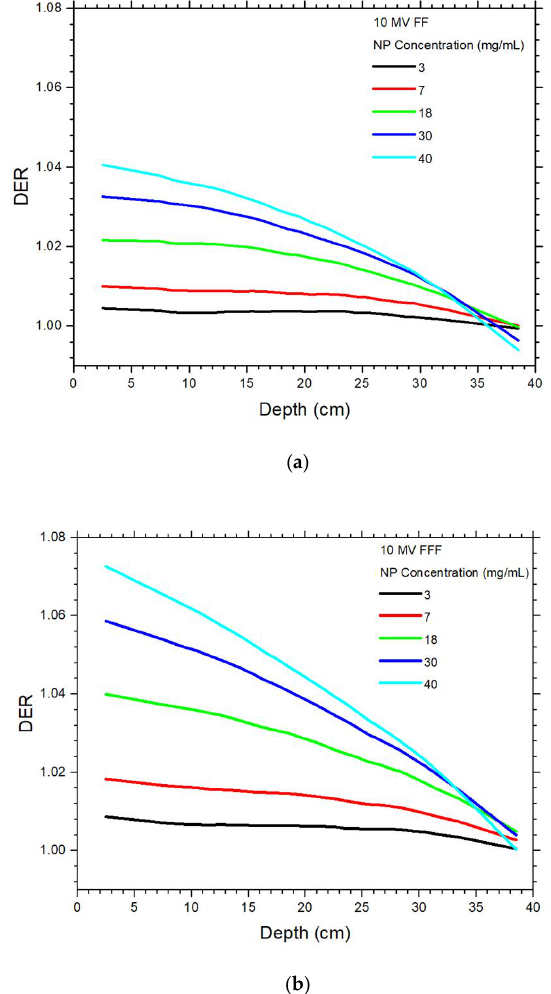
Figure 4. Relationships of dose enhancement ratio and phantom depth with variation of NP concentration using the ( a ) 10 MV FF and ( b ) 10 MV FFF photon beams.